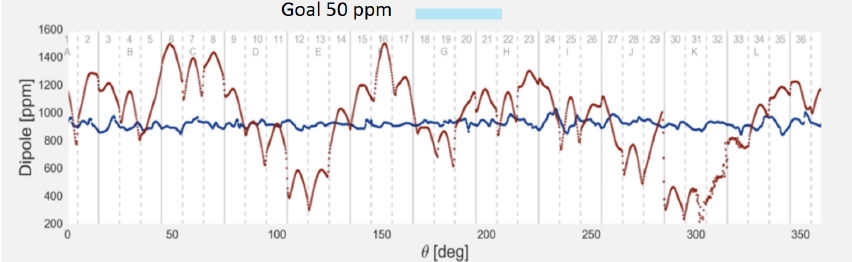
Figure 9. Comparison of the magnetic field before (brown) and after (blue) shimming, laminations, calibration, etc. of the